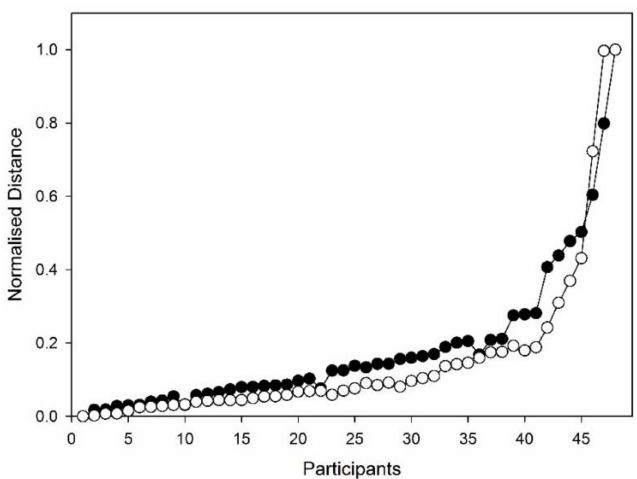
Figure 1. The number-distance plots of the Euclidian ( ) and Pearson (